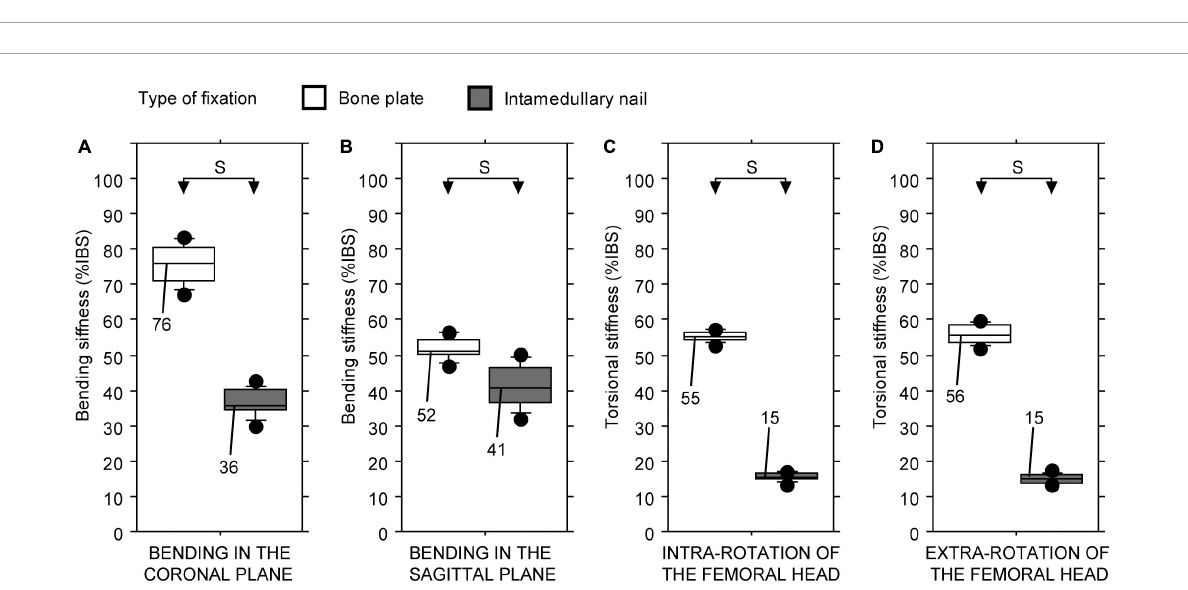
FIGURE5 Bending and torsional stiffness, expressed as a percentage of intact host bone stiffness (%IBS) determined for the intercalary reconstruction with the taper junctions differing in the type of fixation. (A) Bending stiffness in the coronal plane. (B) Bending stiffness in the sagittal plane. (C) Torsional stiffness in intra-rotation direction. (D) Torsional stiffness in extra-rotation direction (S, statistically significant